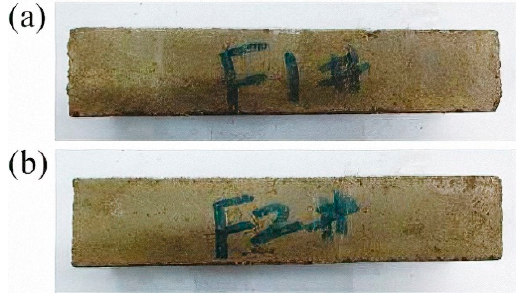
Figure 6. Images of F1 ( a ) and F2 ( b ) specimens after 360 days of hydration.